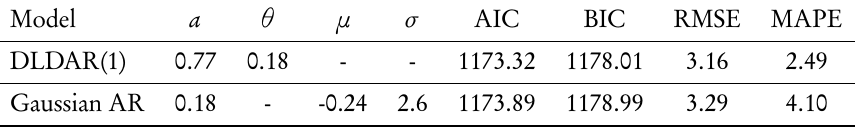
AIC, BIC, RMSE and MAPE values of both DLDAR(1) and Gaussian AR(1) models.